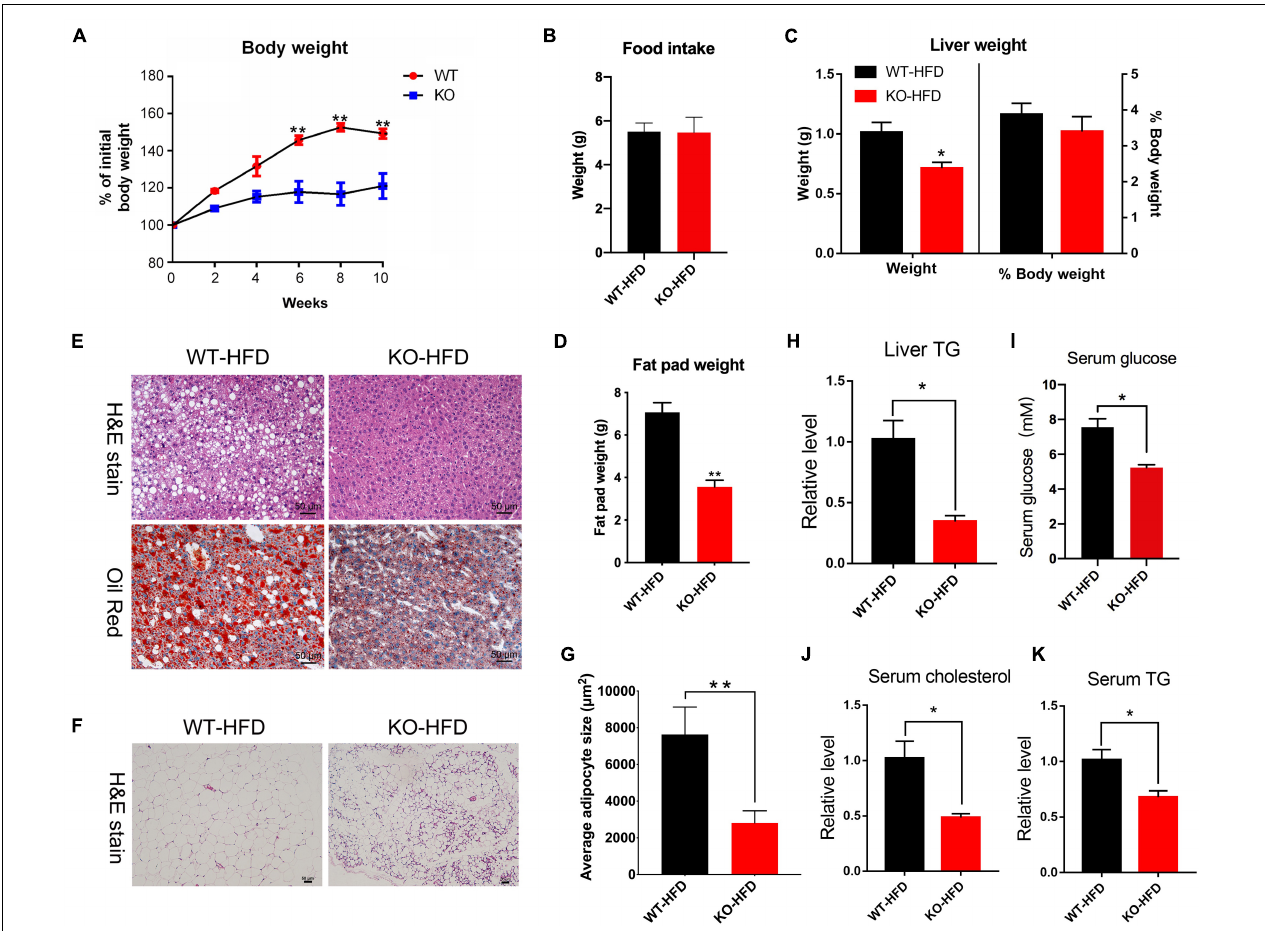
FIGURE 3 | The miR-379/miR-544 cluster KO mice displayed resistance to HFD-induced obesity. (A) The liver growth curve shows that the miR-379/miR-544 cluster KO-HFD mice gain less weight than WT-HFD mice ( n = 5). * P < 0.05 and ** P < 0.01. (B) Measurement of food intake of miR-379/miR-544 cluster KO-HFD mice and WT-HFD mice ( n = 3). (C) Liver weight and the ratio of liver weight to body weight in the miR-379/miR-544 cluster KO-HFD mice and WT-HFD mice ( n = 3). * P < 0.05. (D) Representative images of H&E staining (top) and Oil-red O staining (bottom) of liver sections from WT-HFD (left) or the miR-379/miR-544 cluster KO-HFD (right) mice ( n = 3). Scale bars = 50 µ m. (E) Weight of total fat pads isolated from the miR-379/miR-544 cluster KO-HFD and WT-HFD mice ( n = 3). ** P < 0.01. (F) Representative images of H&E-staining of epididymal fat pads from WT-HFD and the miR-379/miR-544 cluster KO-HFD mice ( n = 3). Scale bars = 50 µ m. (G) Quantitation of adipocyte size between WT-HFD and KO-HFD mice as in panel (F) are shown ( n = 3). ** P < 0.01. (H–K) Measurement of liver TG (H) , serum TG (I) , random serum glucose (J) , and serum cholesterol (K) levels in WT-HFD and KO-HFD mice ( n = 3) are shown, respectively. * P <